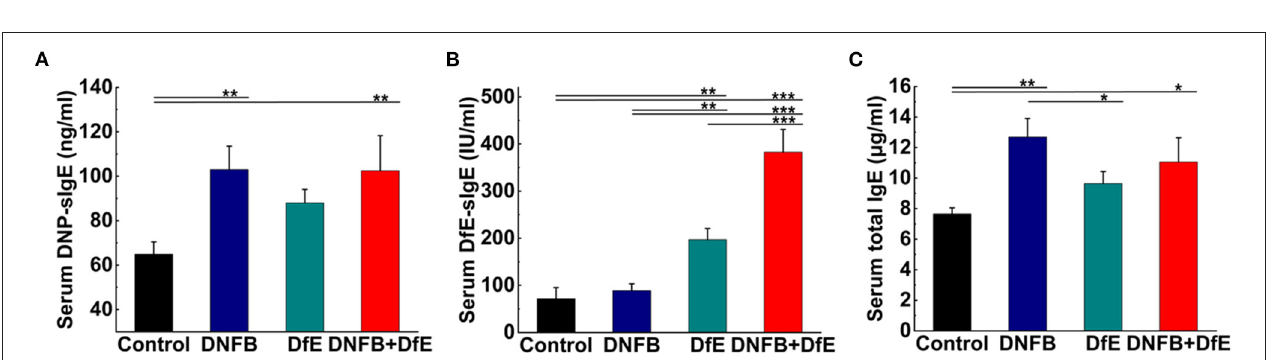
FIGURE 3 | Serum specific IgE and total IgE increased after treatment with DNFB or DfE. ELISA analyses of serum. (A) DNFB specific IgE (DNP-sIgE); (B) DfE-specific IgE; and (C) total IgE. Results are representative of three mice in each group ( n = 4 mice). Data are shown as mean ± SD. * p < 0.05, ** p < 0.01, and *** p < 0.001.